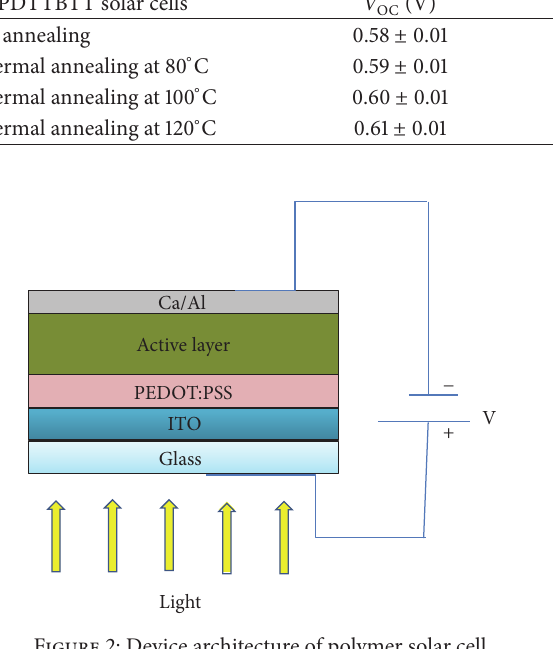
Figure 2: Device architecture of polymer solar cell.